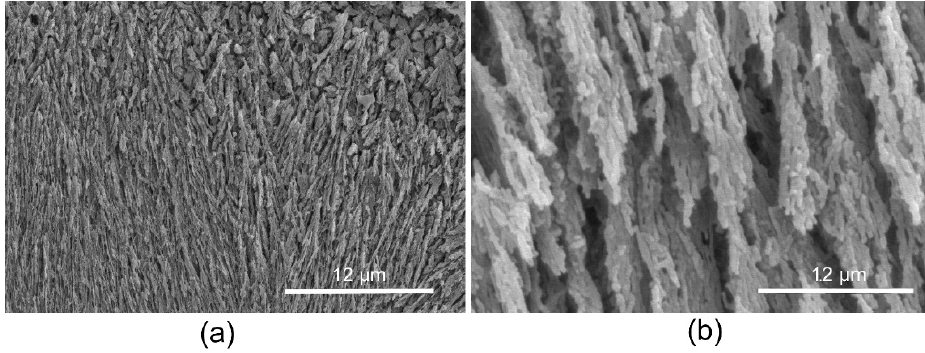
Figure 4. The ASPHP structure in the inner layer of Spiraserpula caribensis. ( a ) Longitudinal section, general view; ( b ) longitudinal section, showing substructure composed of elongated rods.